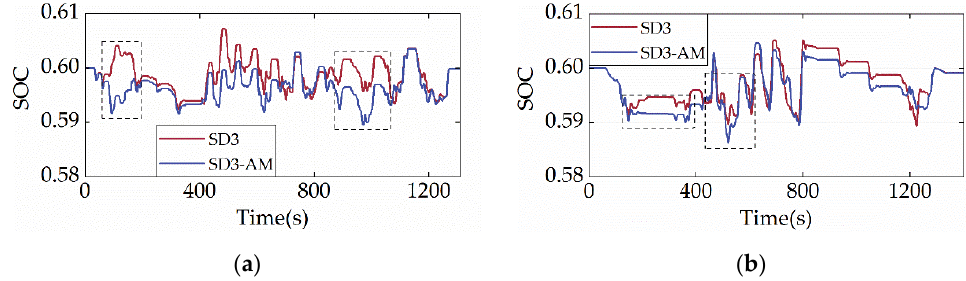
Figure 17. SOC trajectories under different driving cycles. ( a ) CHTC-B; ( b ) WVUCITY.